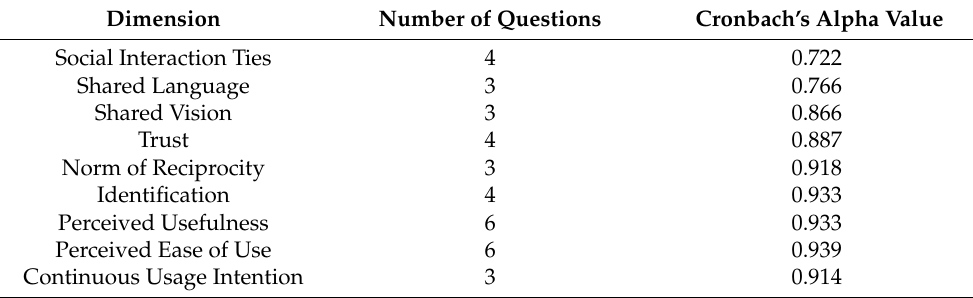
Table 5. Reliability analysis table.